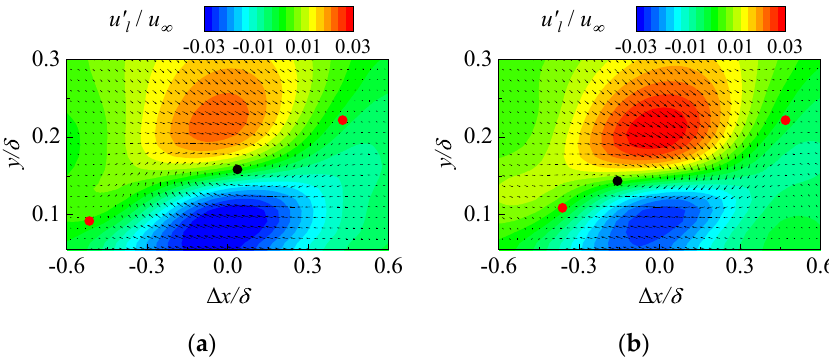
Figure 7. Conditional averaging of large-scale flow field: ( a ) None; ( b ) Control. According to the conditional mean contours of the small-scale flow fluctuation velocity field in Figure 8, both positive and negative pulsations in the controlled flow field are enhanced, and the small-scale vortex structure becomes more active. These results can be attributed to two aspects: (1) small-scale perturbance continuously arises from the synthetic jets; (2) the disturbance disrupts the large-scale coherent structures.